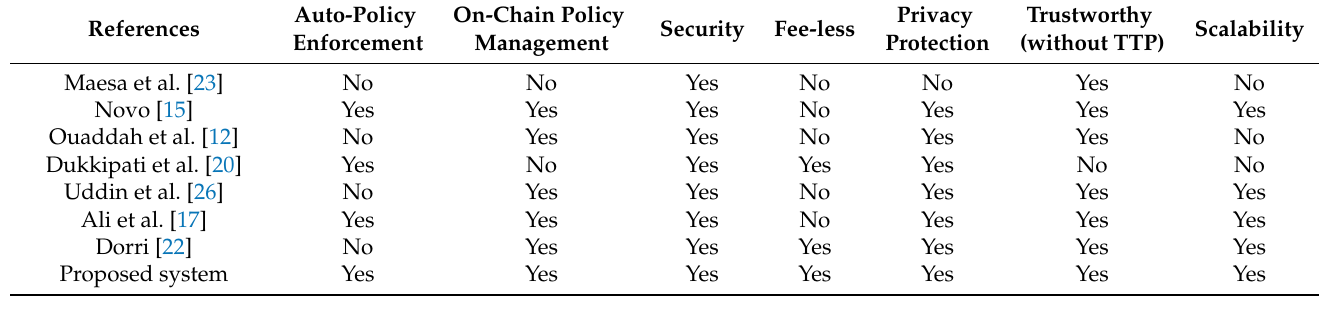
Table 1. Comparison of some blockchain-based access-control schemes with the proposed framework.